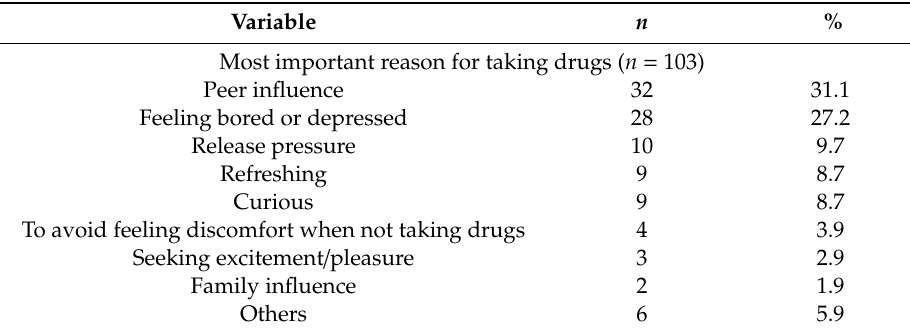
Table 2. Reasons for drug-taking.